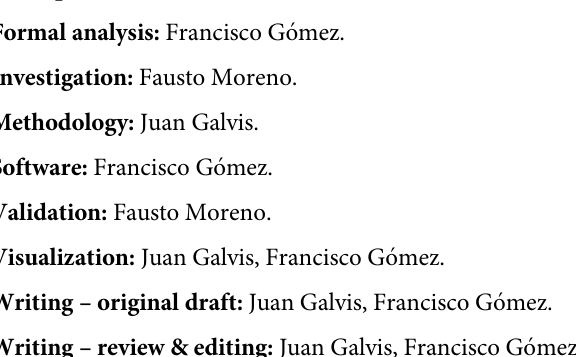
S1 Table. Rankings of municipalities computed for 2016